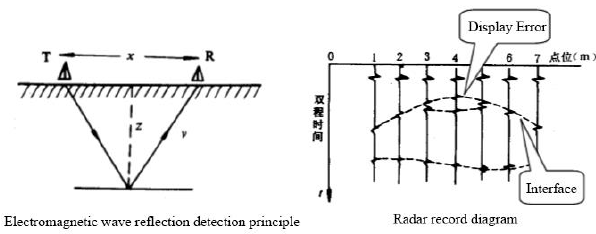
Figure 6 Working principle and recording diagram of GPR